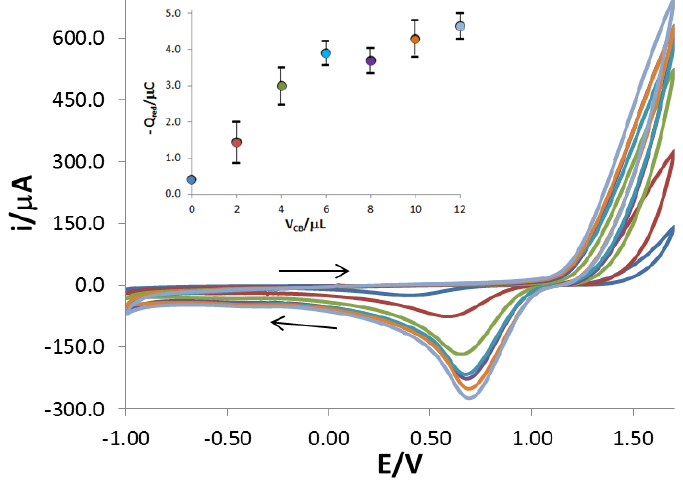
Figure 2. Tenth voltammetric scan obtained at the SPE and at different CB/SPEs in 1 M H 2 SO 4 , 0.1 M KCl solution by varying the amount of CB deposited on the electrode surface; 0.05 V/s potential scan rate. The relevant trend of the charge spent in the reduction peak vs. the volume of CB dispersion deposited is reported in the inset. The error bar length accounts for twice the standard deviation of four replicates for each deposition condition.